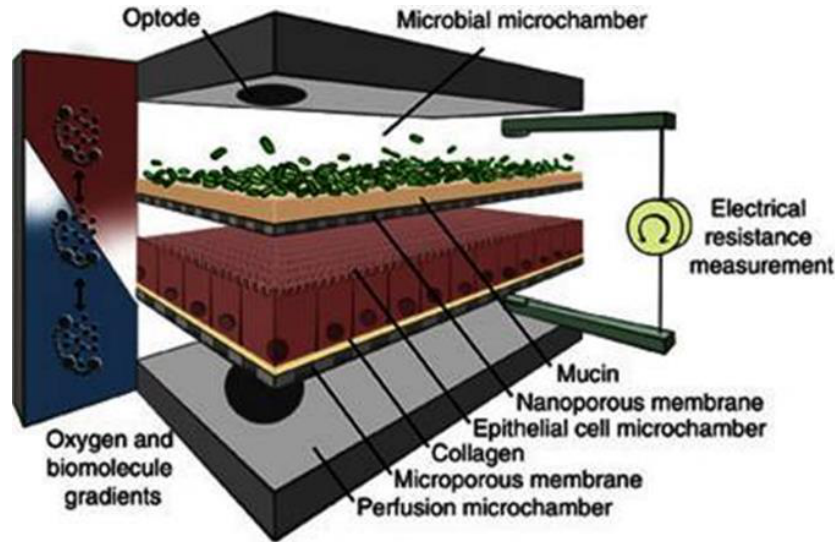
Figure 13. Schematic overview of the human–microbial crosstalk (HuMiX) model including human epithelial cells and gastrointestinal microbes. Adopted from [6], Springer Nature, 2016.